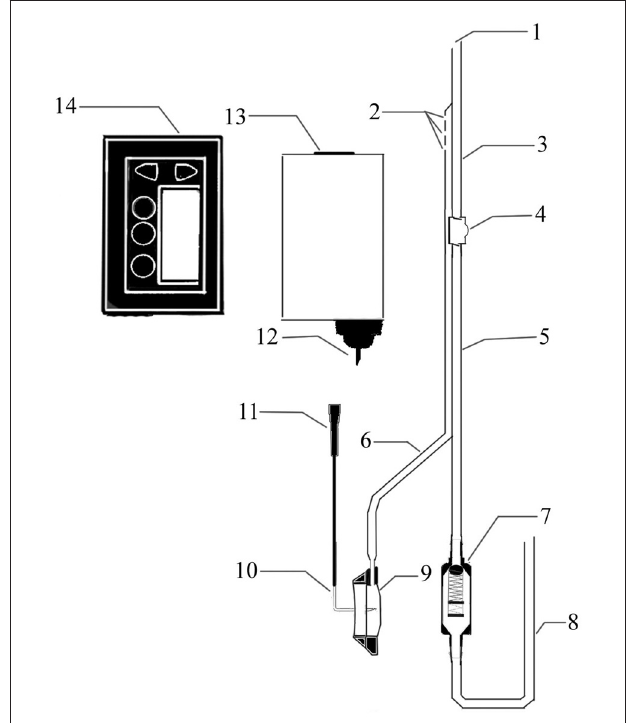
FIGURE 1 | Structure diagram of the cerebrospinal fluid (CSF) circulatory assistance device. 1. CSF outlet; 2. Artificial CSF (ACSF) inlet; 3. Intraventricular double lumen catheter; 4. A one-way liquid storage bag; 5. Subcutaneous double lumen catheter; 6. Transfusion connecting tube; 7. Pressure control valve; 8. Peritoneal cavity catheter; 9. Infusion seat; 10. L-shaped nondestructive needle; 11. Needle connecting head; 12. Fluid needle; 13. Pre-packaged ACFS; 14. Infusion